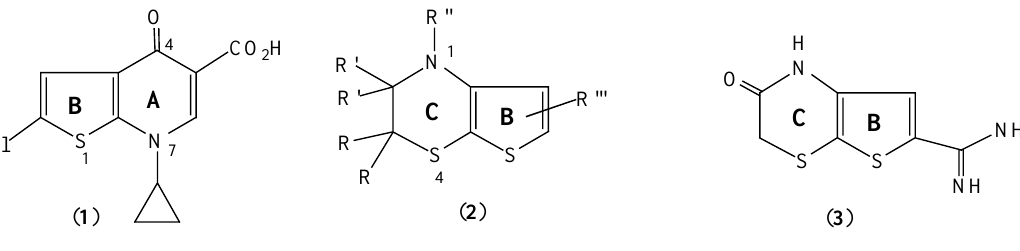
Figure 1. Structures of 4-oxothieno[2,3- b ]pyridine ( 1 ) and thieno[2,3- b ][1,4]thiazines 2 , 3 .